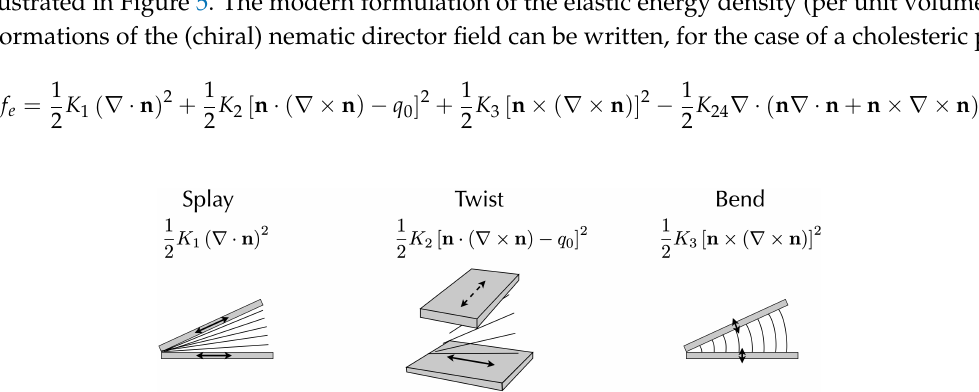
Figure 5. Illustrations of the three elemental director field deformations splay, twist and